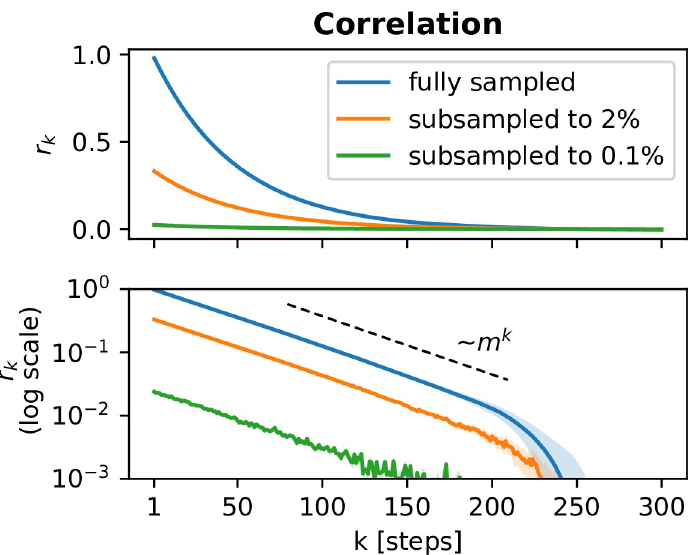
Fig 3. The amplitude of correlation coefficients decreases under subsampling, whereas the intrinsic timescale τ and the branching parameter m (characterized by the slope of the r Coefficients were determined by the toolbox for a fully sampled and binomially subsampled branching processes